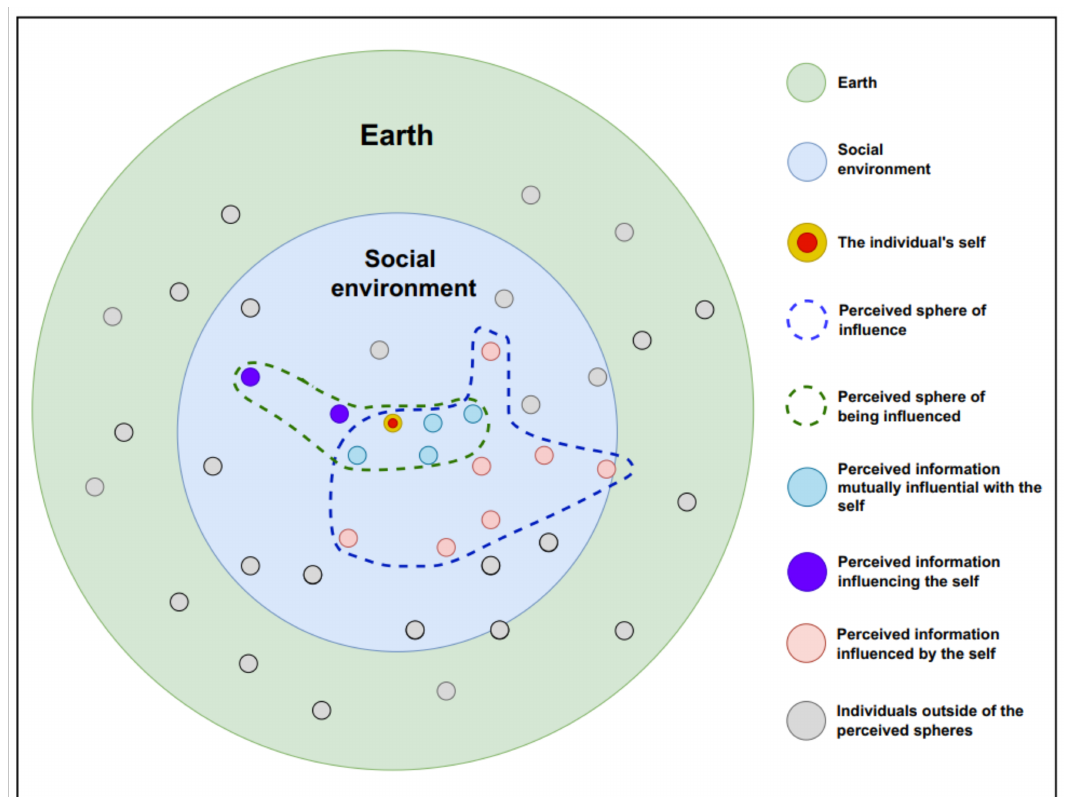
Figure 1. Scenarios of perceptions in the